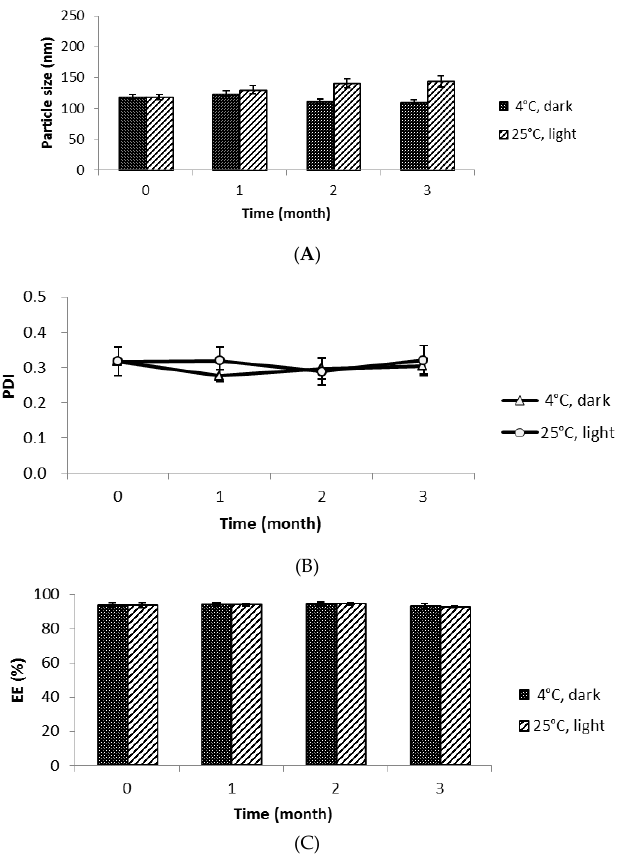
Figure 7. The stability of freeze-dried PR-NLCs over the course of three months. ( A ) The particle size; ( B ) PDI; ( C ) EE ( n = 3, mean ±